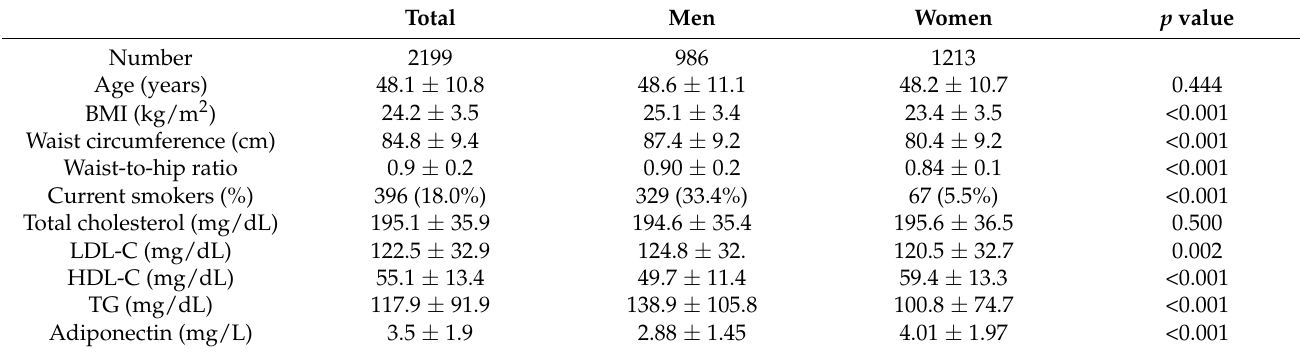
Table 1. Clinical phenotypes and biochemical profiles of the TWB